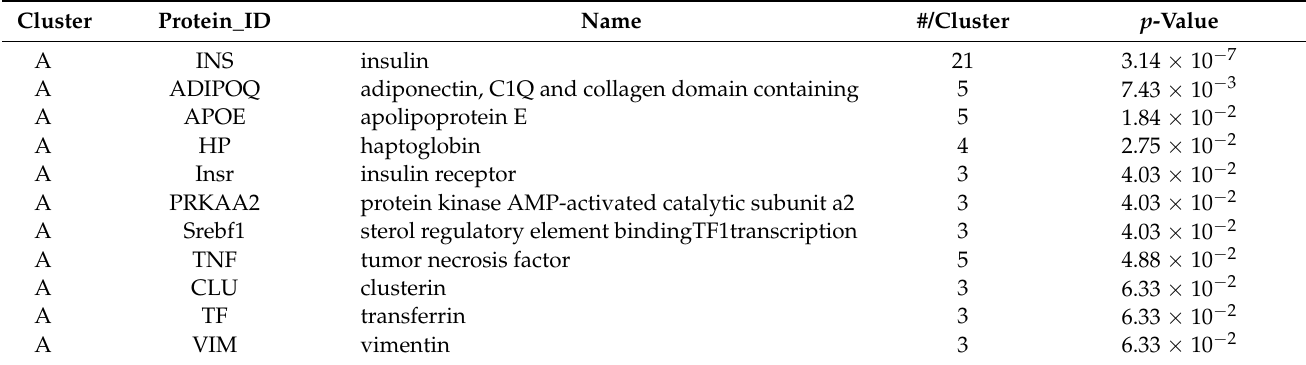
Table 3. Protein Enrichment Per Cluster 1